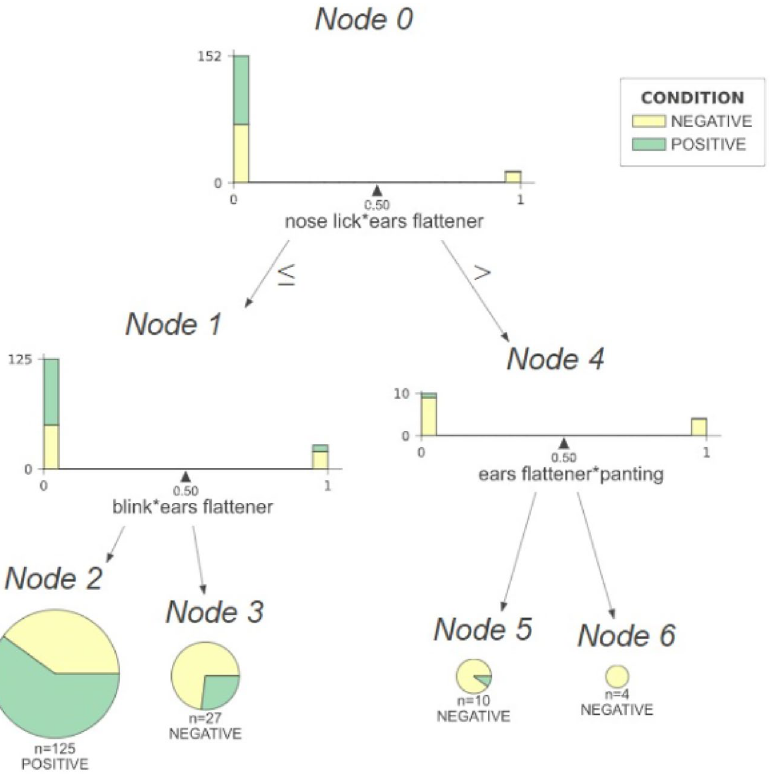
Figure 5. Decision Tree using pairs of DogFACS variables. Accuracy: 0.652463, Precision: 0.651149, Recall: